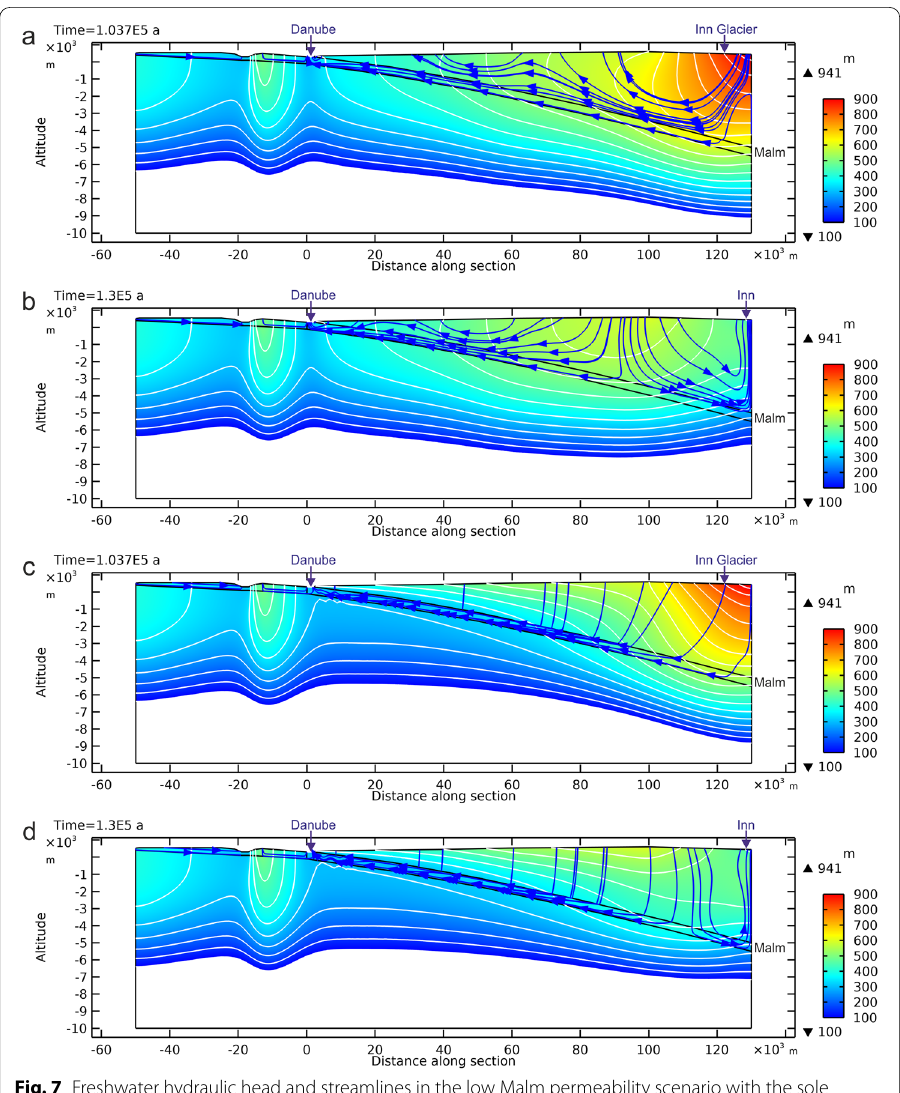
Fig. 7 Freshwater hydraulic head and streamlines in the low Malm permeability scenario with the sole hydraulic effect of the Inn Glacier (i.e. model run A introduced in Fig. 3) a at the Last Glacial Maximum 26.3 ka ago (time 1.037E5 a), and b at present (time 1.3E5 a). By comparison, freshwater hydraulic head = = and streamlines in the high Malm permeability scenario with the sole hydraulic effect of the Inn Glacier (i.e. model run B) c at the Last Glacial Maximum 26.3 ka ago (time 1.037E5 a), and d at present (time 1.3E5 = = a). Streamlines indicate Darcy’s velocity field resulting from model properties and a constant surface temperature. White lines are isopotential levels at 50 m intervals. Vertical exaggeration equals